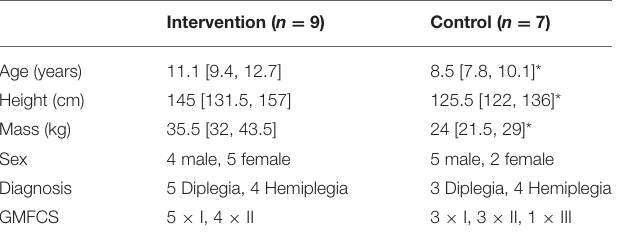
TABLE 2 | Characteristics of participants completing the intervention. Intervention ( n = 9) Control ( n = 7)